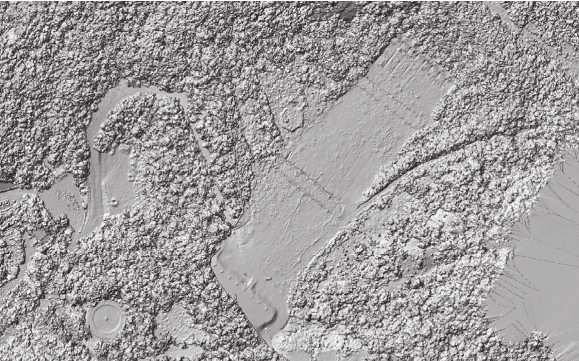
Figure 7: Generation of Digital Surface Model (DSM). Table 2: Generation of vector data using QGIS (in